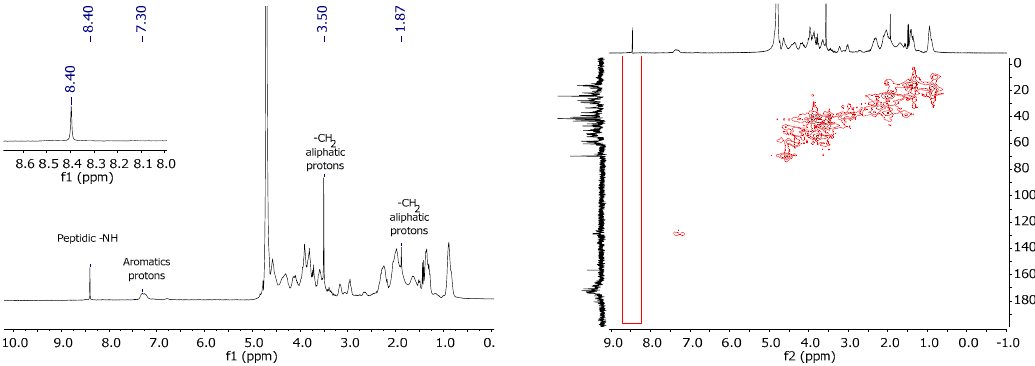
Figure 1. 1 H- and 1 H- 13 C HMQC spectra of hydrolysed collagen protein in D 2 O.